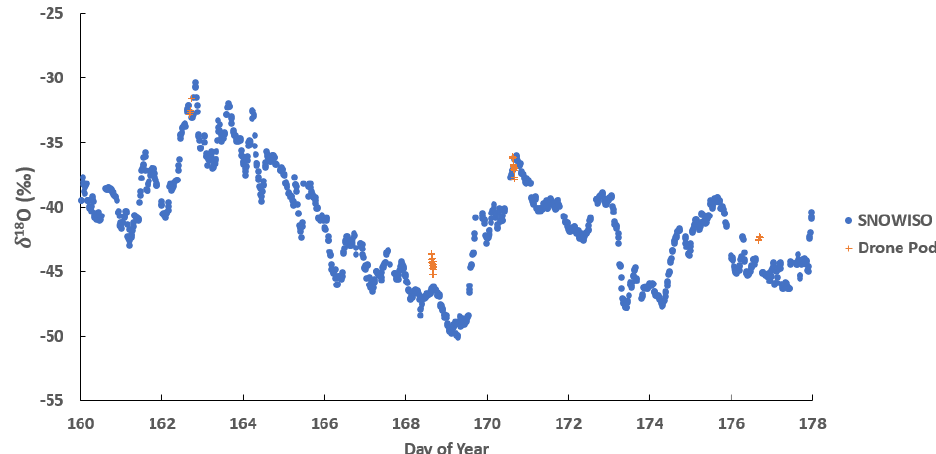
Figure A4. Comparison in δ 18 O between the tower setup present at the EastGRIP camp in 2019 and 2m pod intercomparison measurements. Drone pod measurements on 163DOY (day of year) and 176DOY correspond to flask measurements taken at 2m during a flight mission. All measurements from both tower and UAV are tied to the same isotopic water standards listed in Table 1.